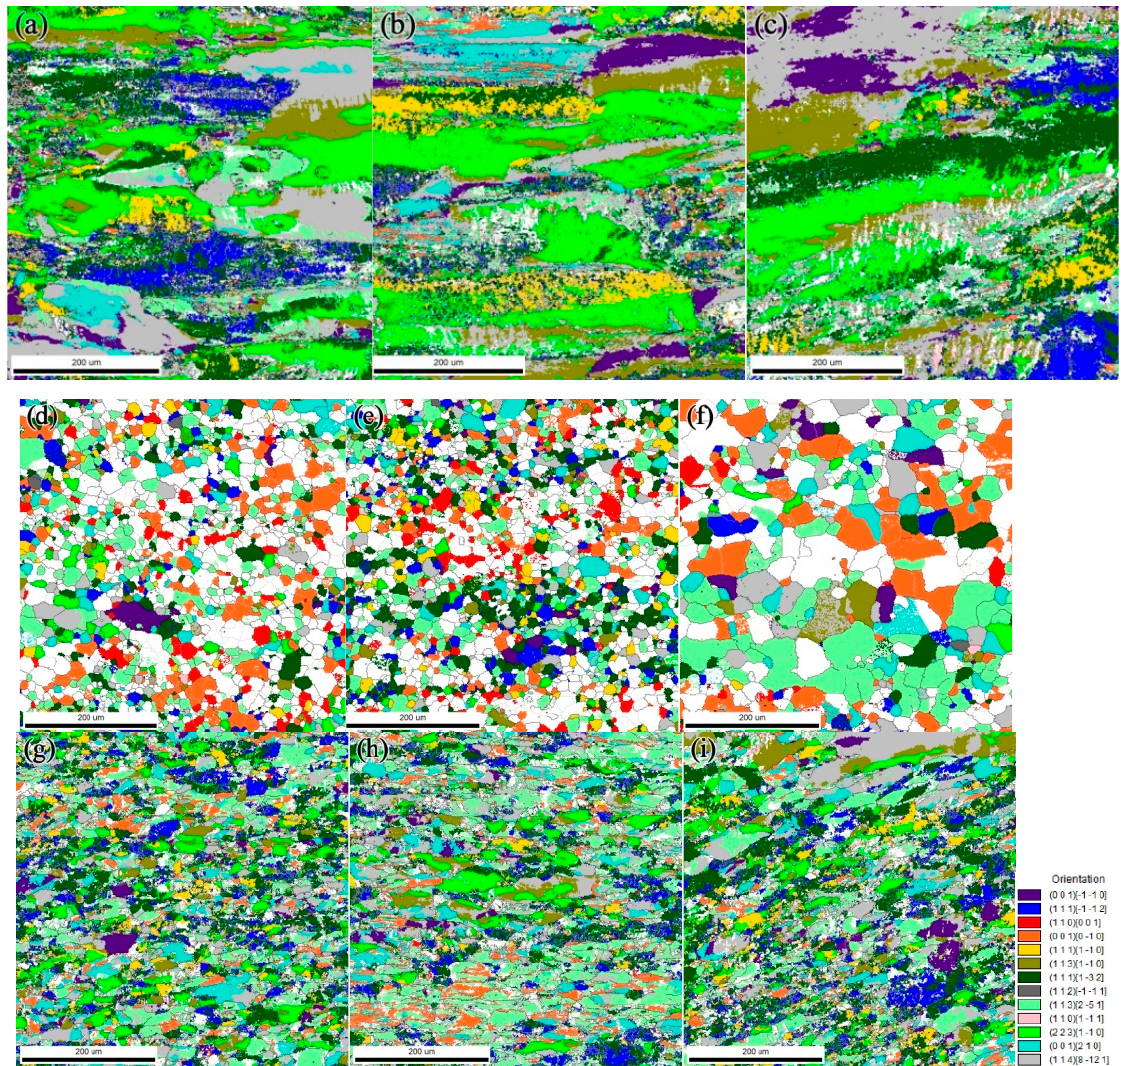
Figure 3. Orientation maps of two ‐ stage cold rolling with different slab heating temperatures: ( a ) 1170 °C, first cold rolling, ( b )1220 °C, first cold rolling, ( c )1270 °C, first cold rolling, ( d ) 1170 °C, intermediate annealing, ( e ) 1220 °C, intermediate annealing, ( f ) 1270 °C, intermediate annealing, ( g ) 1170 °C, second cold rolling, ( h ) 1220 °C, second cold rolling, ( i ) 1270 °C, second cold rolling.